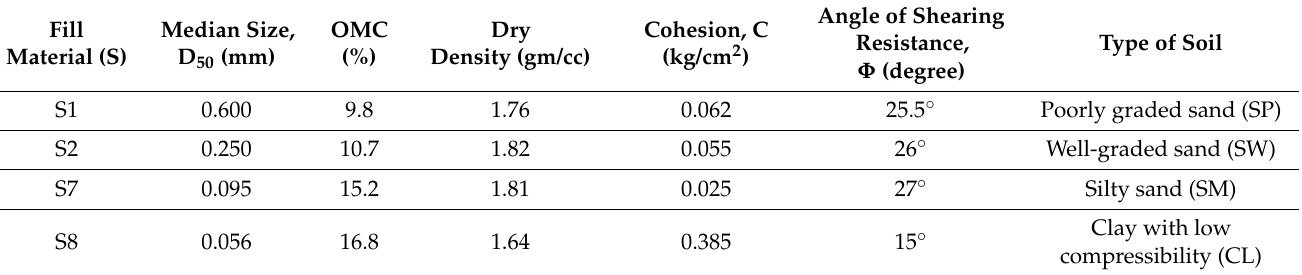
Table 1. Properties of fi ll material used for constructing prototype embankment dams.